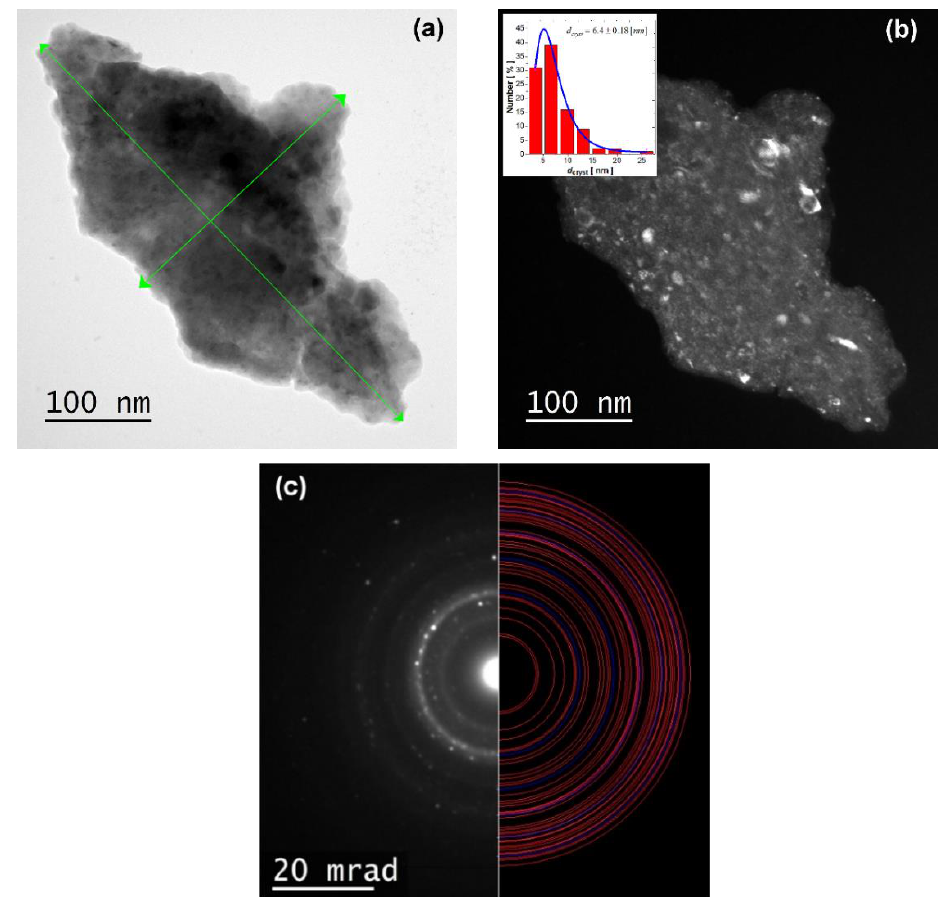
Figure 5. TEM micrographs for the SmCo 5 /α-Fe (5%wt. of α-Fe) sample milled for 10 h: ( a ) bright- field image ( b ); dark-field image with visible crystallites structure. Insert represents crystallite size distribution (CSD) histogram; ( c ) selected area electron diffraction (SAED) pattern indexed with CaCu 5 (red lines) and α-Fe (blue lines) phases.